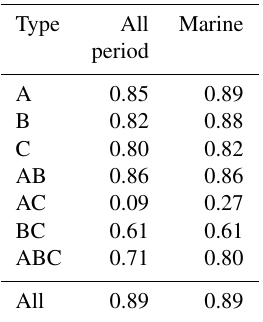
Table 2. Correlation coefficients between number concentrations of fluorescent aerosol particles (FAPs) obtained by WIBS-4A (autoflu- orescent) and biological particles obtained by Bioplorer (DNA nu- clear stain). Type All Marine